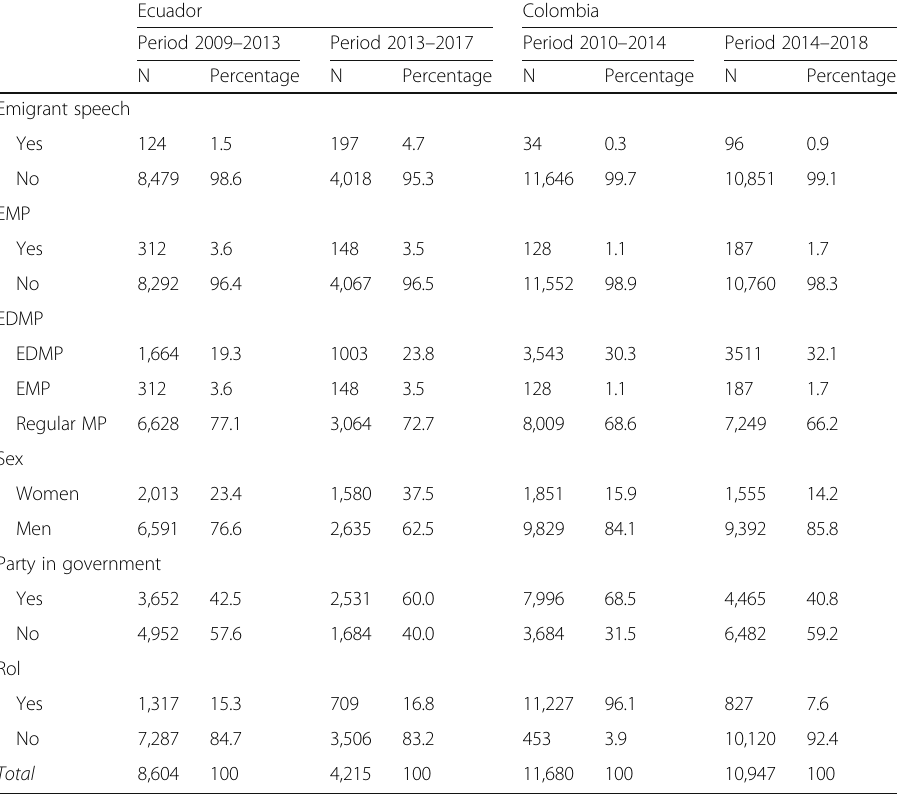
Table 3 Descriptive statistics. Source: Author ’ own Ecuador